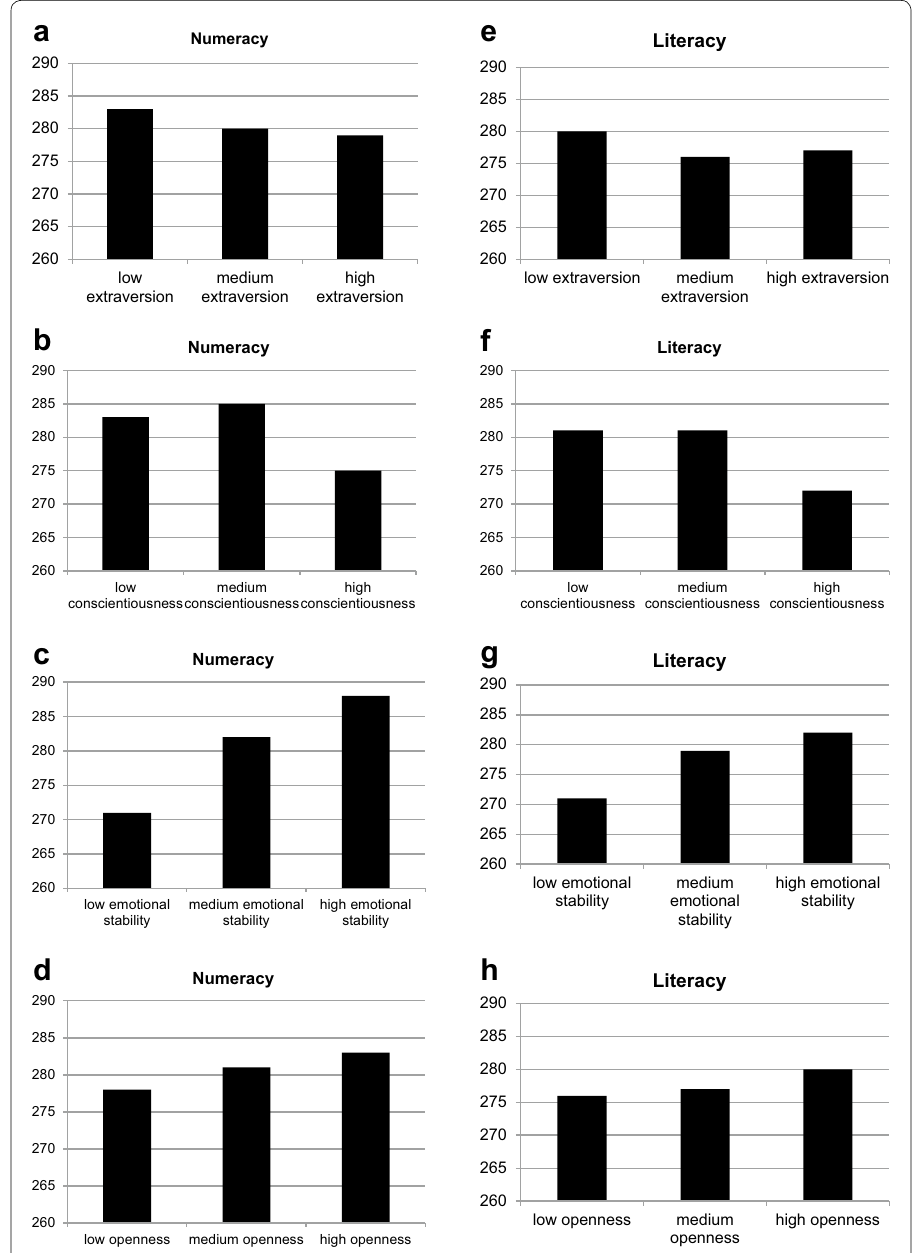
Fig. 1 a – h Associations between the Big Five personality domains and numeracy and literacy (means based on tertile